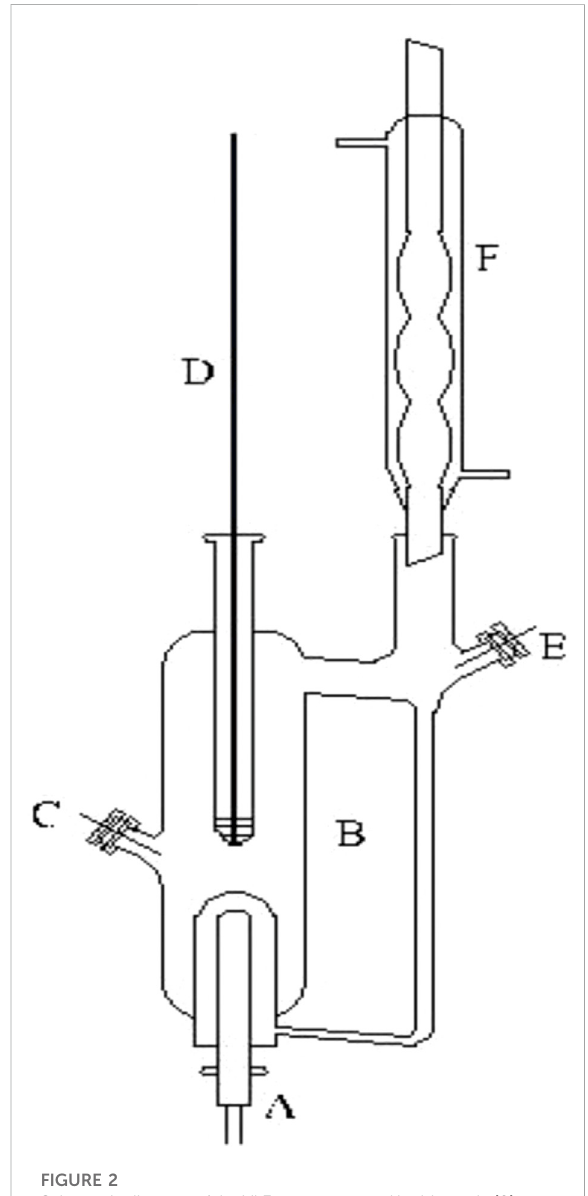
FIGURE 2 SchematicdiagramoftheVLEapparatususedinthiswork: (A) heating mantle, (B) equilibrium still, (C) sampling port, (D) thermometer well, (E) sampling port, and (F)